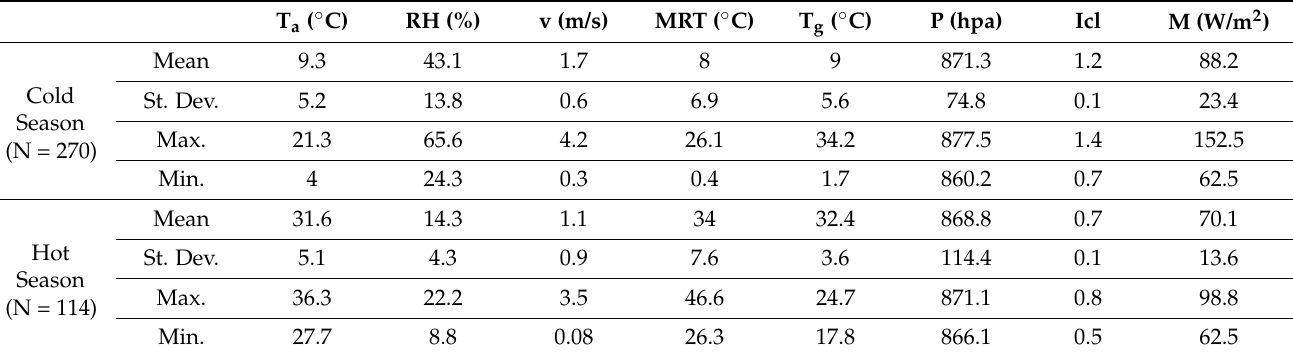
Table 2. Means, standard deviation, and ranges of T a , RH, v, MRT, Tg, P, Icl, and M in summer and winter.